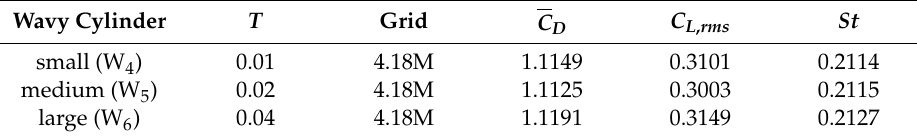
Table 4. Time–step independence verification on wavy cylinder.